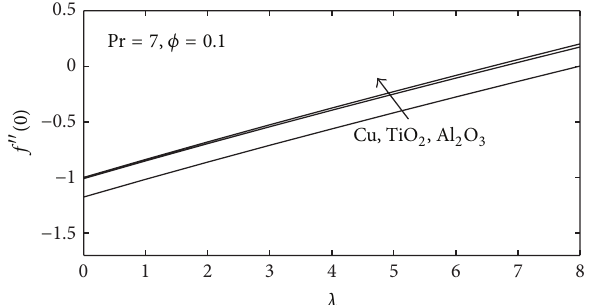
Figure 2: Variation of −𝜃 󸀠 (0) with 𝜆 for different values of 𝜙 when Pr = 7 using Al 2 O 3 nanoparticle.